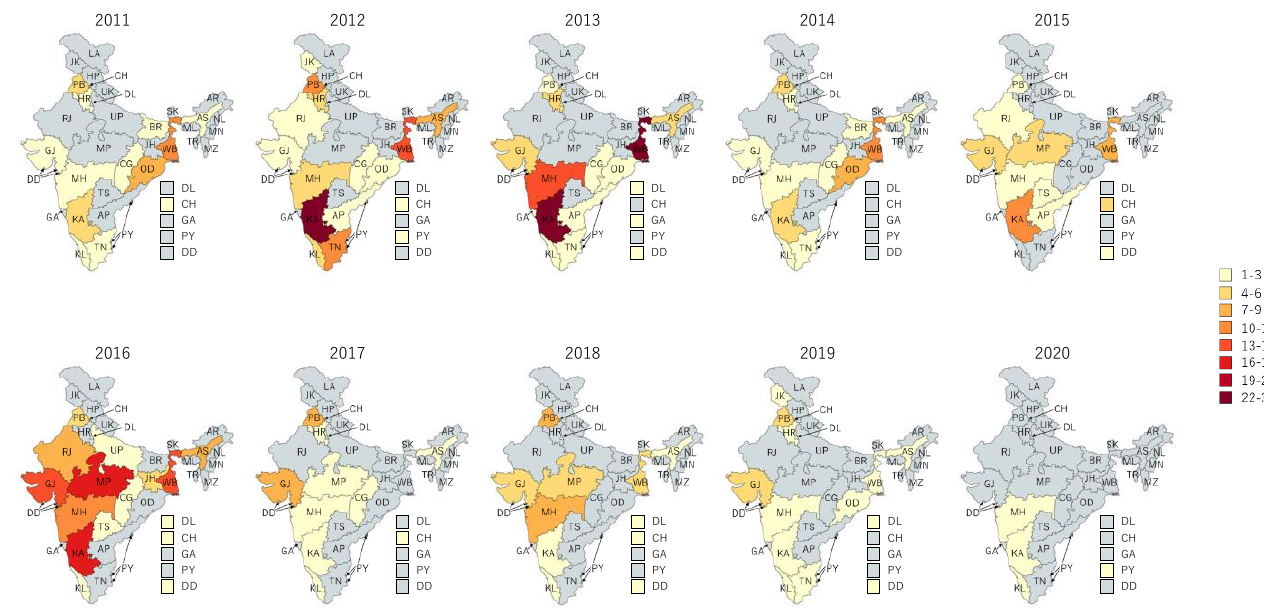
Figure 2. Cholera outbreaks ( n = 565) by year and state, India, 2011 – 2020.